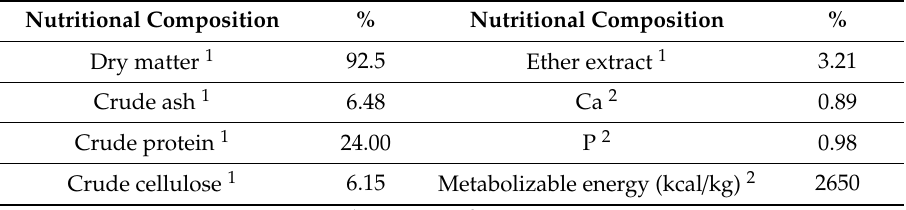
Table 4. Nutrient composition of diet used in the study. Nutritional Composition